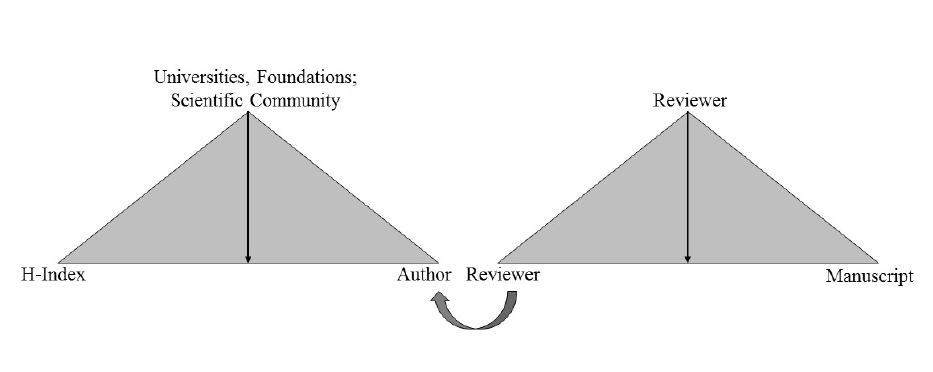
Figure 2 The valuated valuator Source: Authors’ depiction based on Helgesson